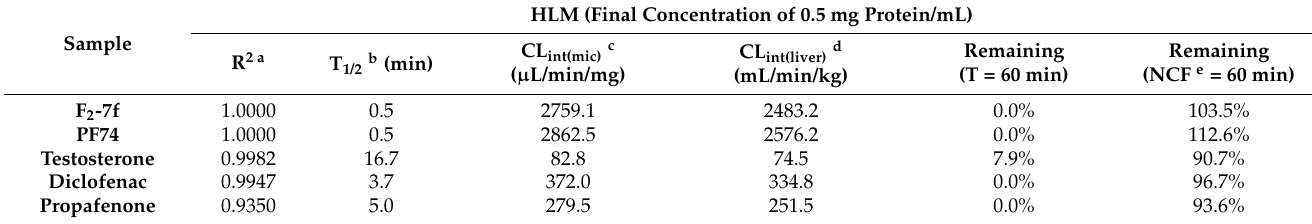
Table 4. Metabolic stability assay in human liver microsomes.